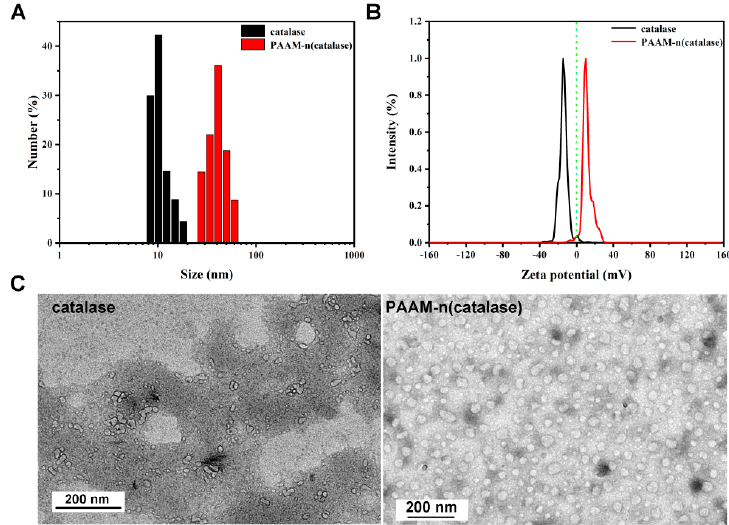
Figure 1. ( A ) The size distribution of native catalase and PAAM-n(catalase); ( B ) the zeta potential of of native catalase and PAAM-n(catalase); ( C ) the representative TEM images of native catalase and